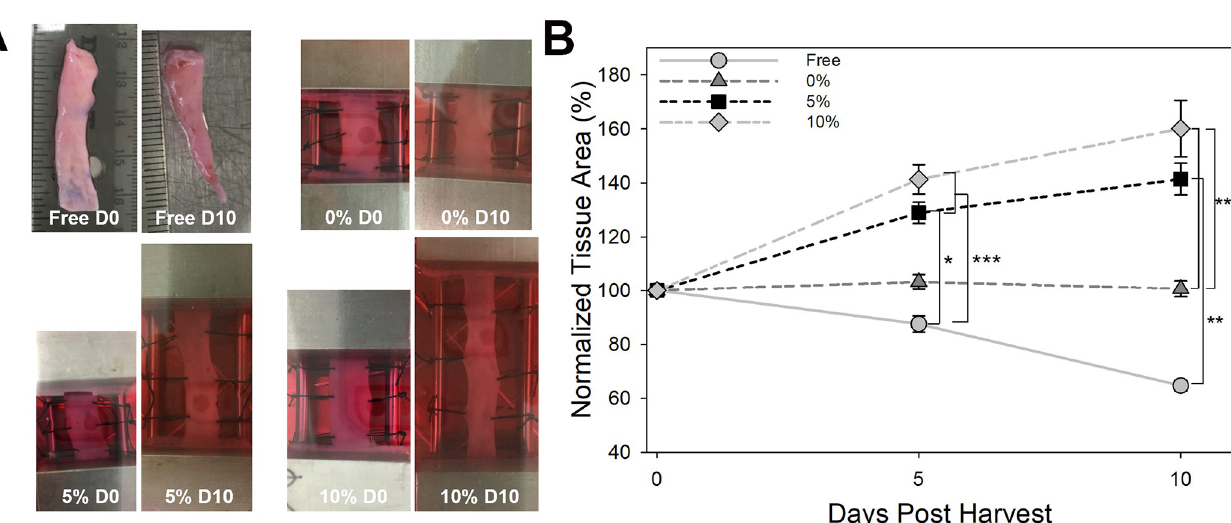
PLOS ONE | https://doi.org/10.1371/journal.pone.0279519 December30,